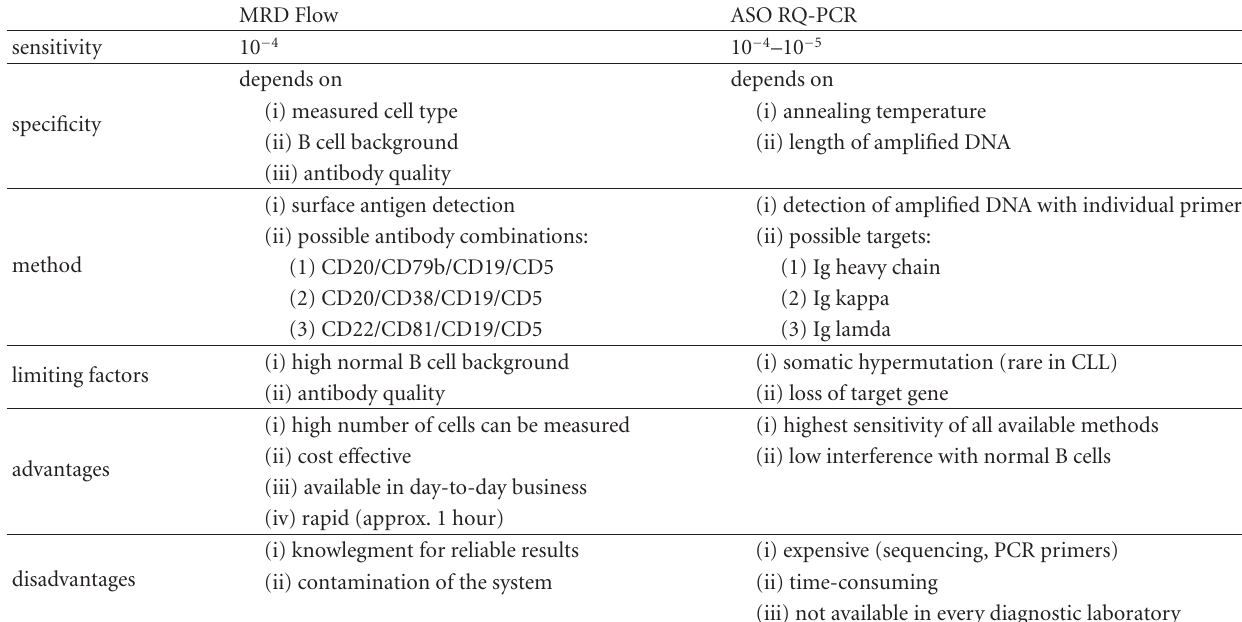
Table 1: Overview about the most important di ff erences between di ff erent MRD detection